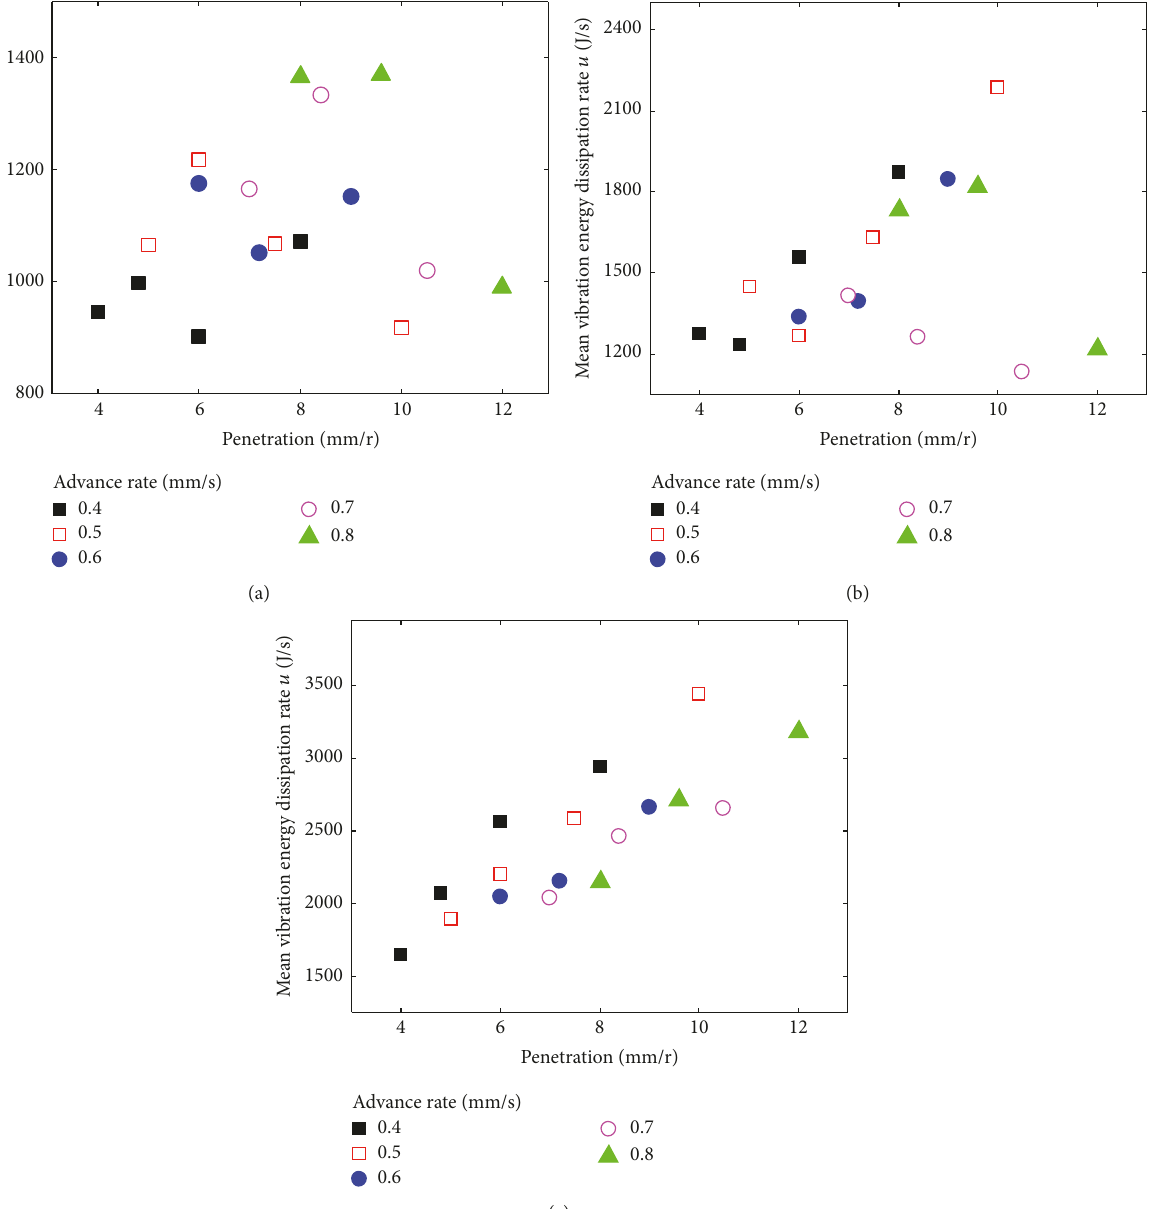
Figure 4: Correlation of mean vibration energy dissipation rate 𝑢 and operational parameters for (a) soft rock, (b) moderately hard rock, and (c) hard